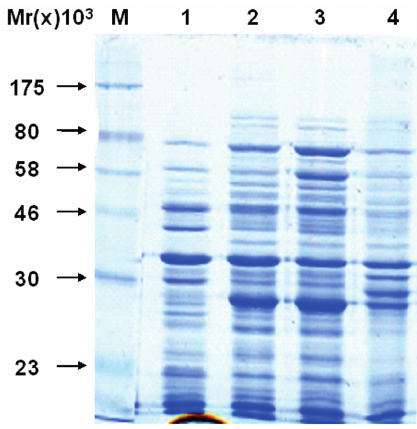
Figure 4. Identification and analysis of the fusion protein by SDS-PAGE. Line M: molecular weight marker: 175 kDa, 80 kDa, 58 kDa, 46 kDa, 30 kDa and 23 kDa; Line 1: whole bacteria of before induce; Line 2: whole bacteria of after induce; Line 3: supernatant of the ultrasound crushing; Line 4: precipitate of the ultrasound crushing.